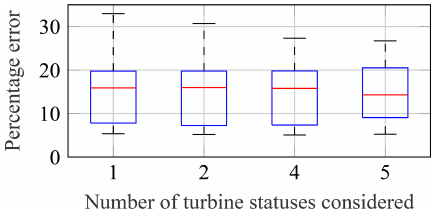
Figure 18. Percentage errors of predicted yearly damage values us- ing an ANN compared to real yearly damage values. Data separated according to different turbine statuses (cf. Fig. 16).